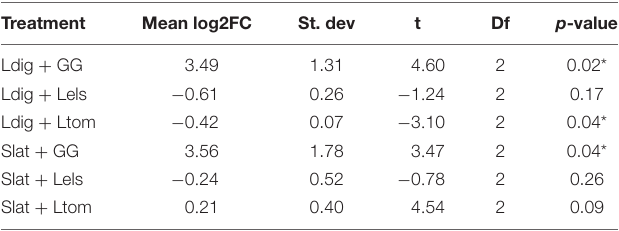
Ldig = L. digitata, GG = addition of oligoguluronates, Lels = L. elsbetiae, Ltom = L. tomentosoides, Slat = S. latissima. Significant differences of t-test are indicated by asterisks